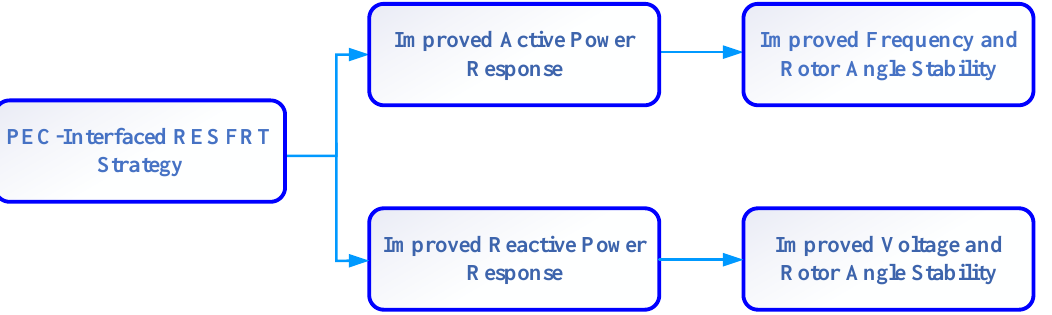
Figure 18. Influence of the fault ride-through strategy on stability.